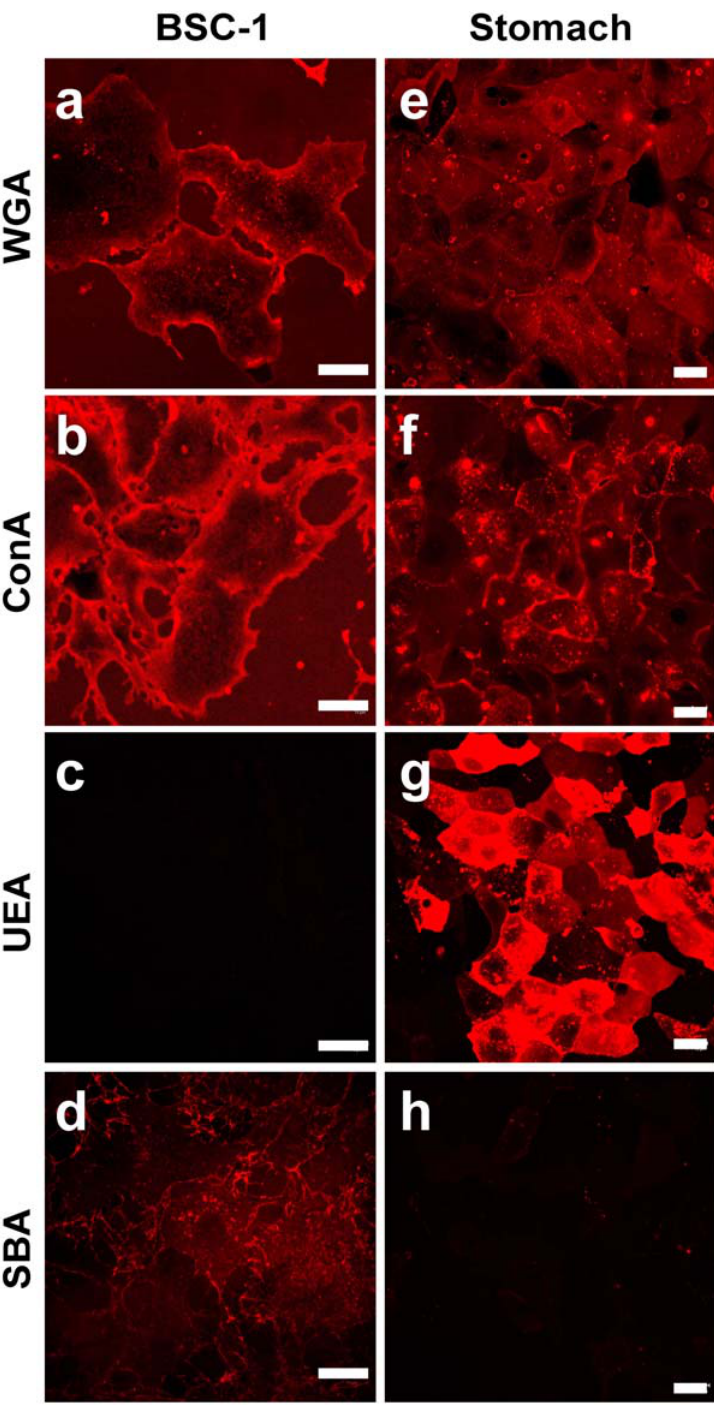
Figure 1. Certain lectins strongly stain the surface of live BS-C-1 cells and SSM cells. Living BS-C-1 cells are strongly stained with fluorescently labeled WGA (a) and ConA (b), but not with UEA (c) and SBA (d). SSM cells are stained with WGA (e), ConA (f) and, most intensely, with UEA (g) but not with SBA (h). Bars=20 m m.